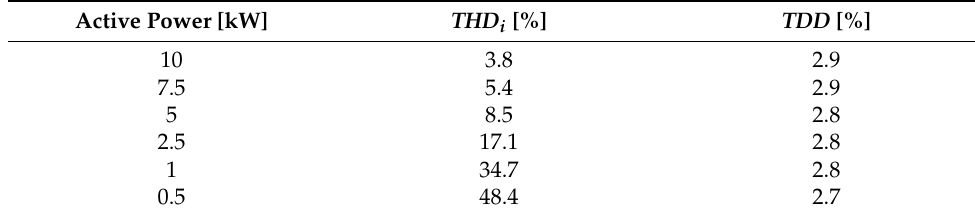
Table 2. THD i vs. active power [15].